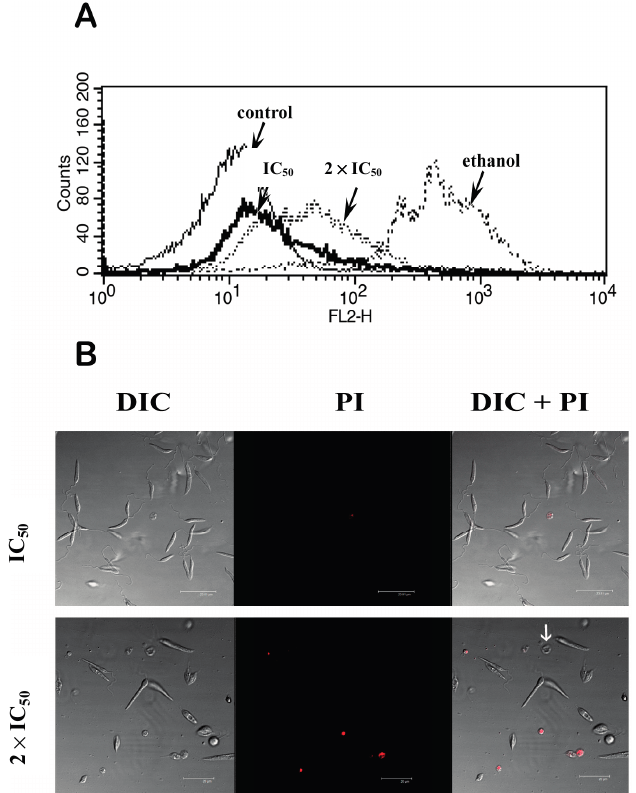
Figure 7. The effects of DME treatment on the promastigote plasma membrane integrity ( A ) Overlay flow cytometry histograms of control and treated cells submitted to PI staining. A slight increase in PI fluorescence signal could be observed in cells treated with 2 × IC of DME, whereas strong PI labeling could be observed in ethanol-treated 50 and 2 × IC of DME and parasites. ( B ) Confocal images cells treated with 1 × IC 50 50 submitted to staining with PI. Note the presence of cells with severely altered morphology not stained with PI (white arrow). DIC = Differential Interference